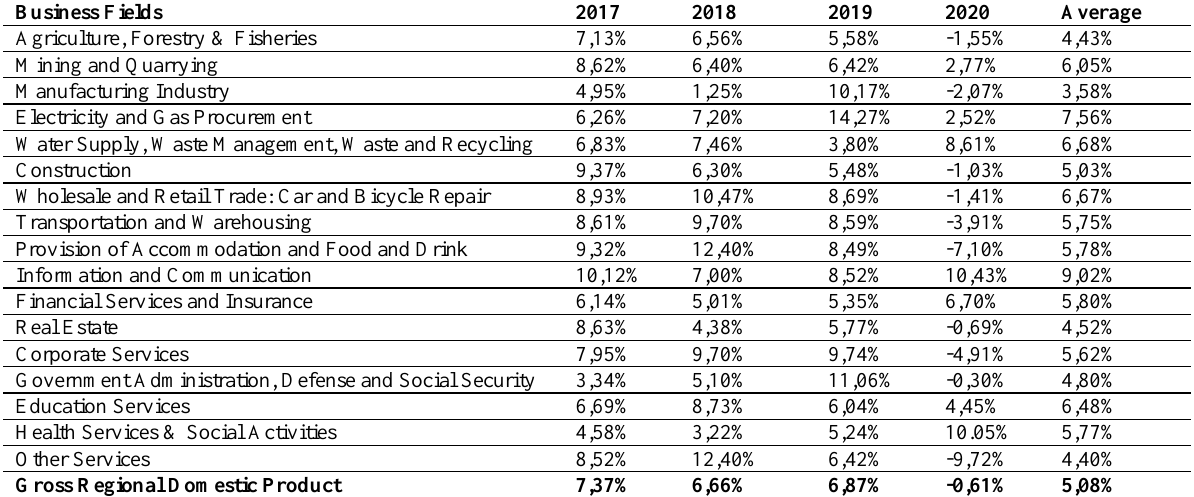
Table 3: Growth Rate of Gross Regional Domestic Product and Sector Growth in Takalar Regency